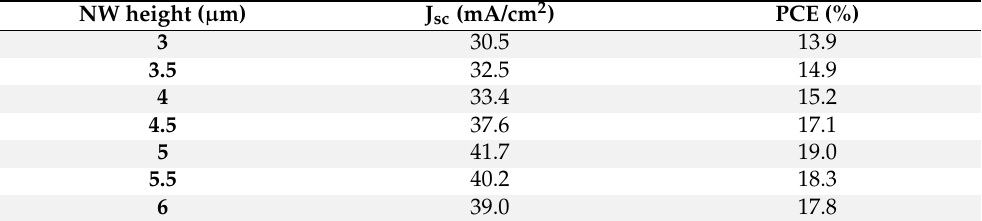
Table 7. Short-circuit current density and overall efficiency for different NW lengths.